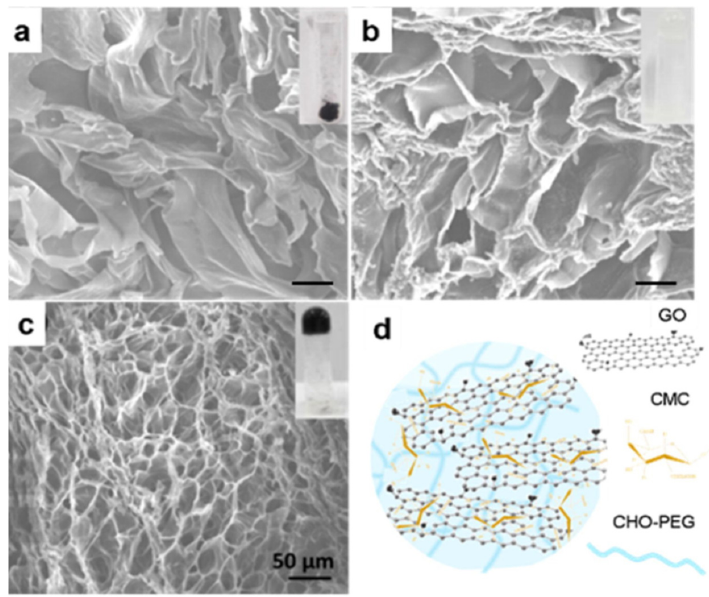
Figure 8. SEM images of: ( a ) CMC/r-GO powder; ( b ) CMC/CHO/PEG hydrogel; ( c ) CMC/r-GO/CHO/PEG hydrogel; and ( d ) illustration of CMC/r-GO/CHO/PEG hydrogel. The insets show photographs of the corresponding samples. Reproduced from Ref. [82] with permission from ELSEVIER.